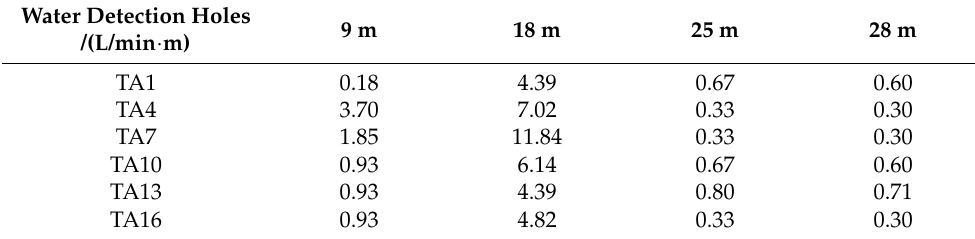
Table 16. ZDDK365+300 to +275 (1.2 MPA).